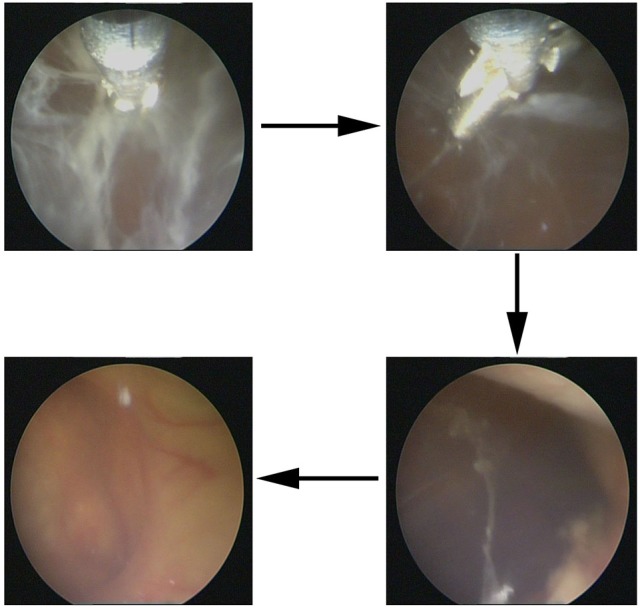
Abscess clearance on a ventriculoscope. Large amount of cellulose deposition in the ventricles were observed on a ventriculoscope, and the lesion was infected, which needed neurosurgery.